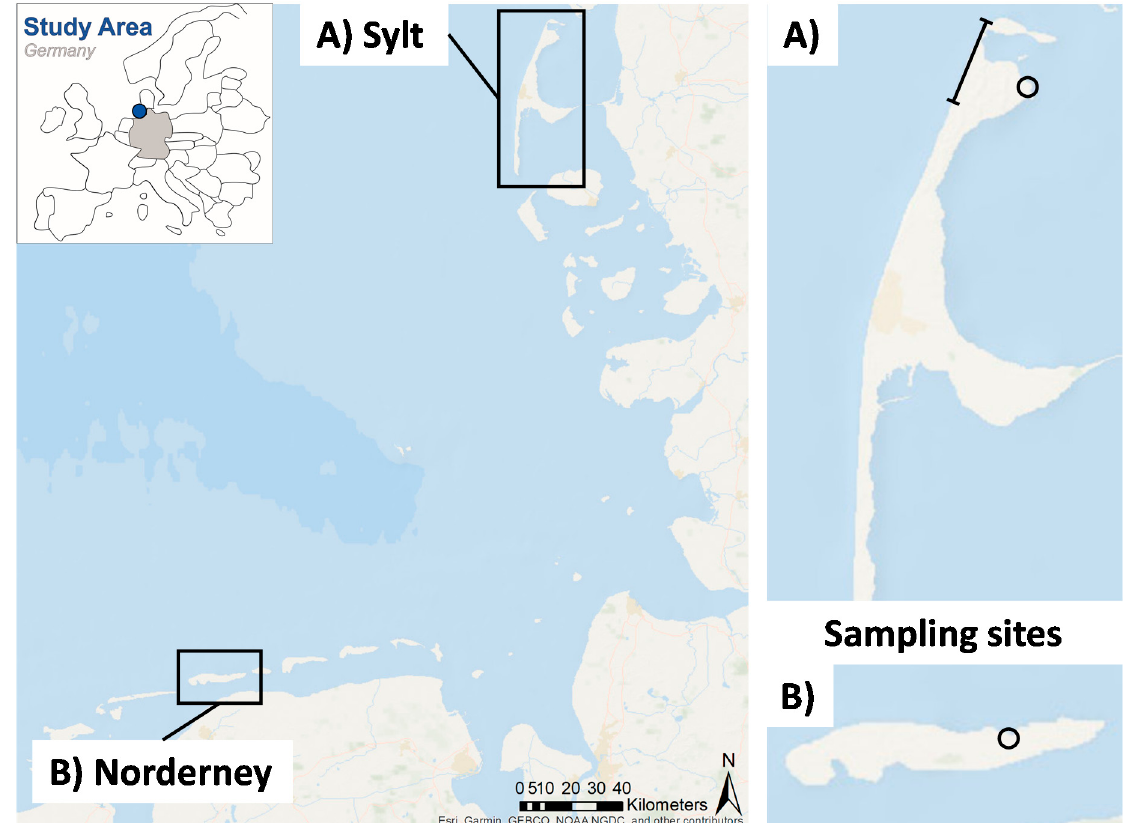
Figure 2. Overview map of the sampling sites (marked black). ( A ) Norderney: the material was samples within a radius of approx. 250 m in a chain of dunes south of the “Schlopp” (garbage hotspot), ( B ) Sylt: the sampled section reached from „List Weststrand Strandsauna“ to “List Westfeuer am Ellenbogen” and additional material was sampled at “List Oststrand Wattenmeer.” (Figure: Simone Lechthaler, Johann Hee).